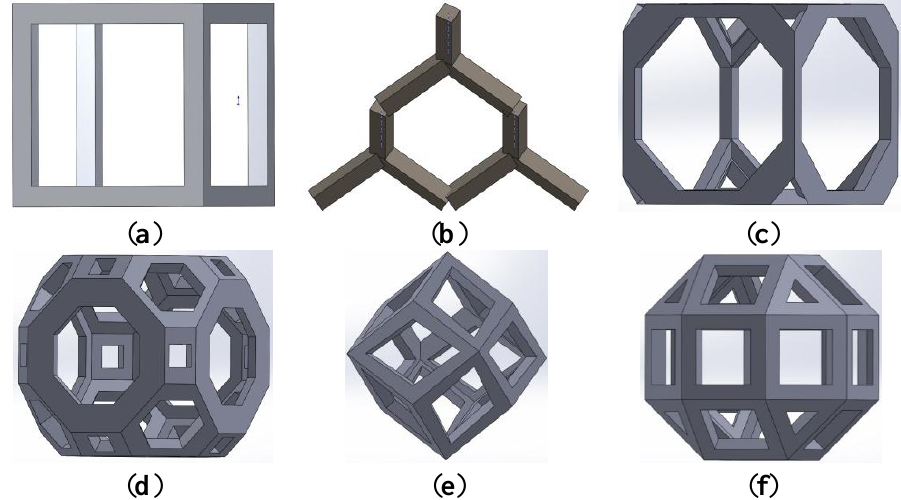
Figure 1. Schematic drawings of the unit cells used in the porous structure: ( a ) Cubic; ( b ) Diamond; ( c ) Truncated cube; ( d ) Truncated cuboctahedron; ( e ) Rhombic dodecahedron; ( f )